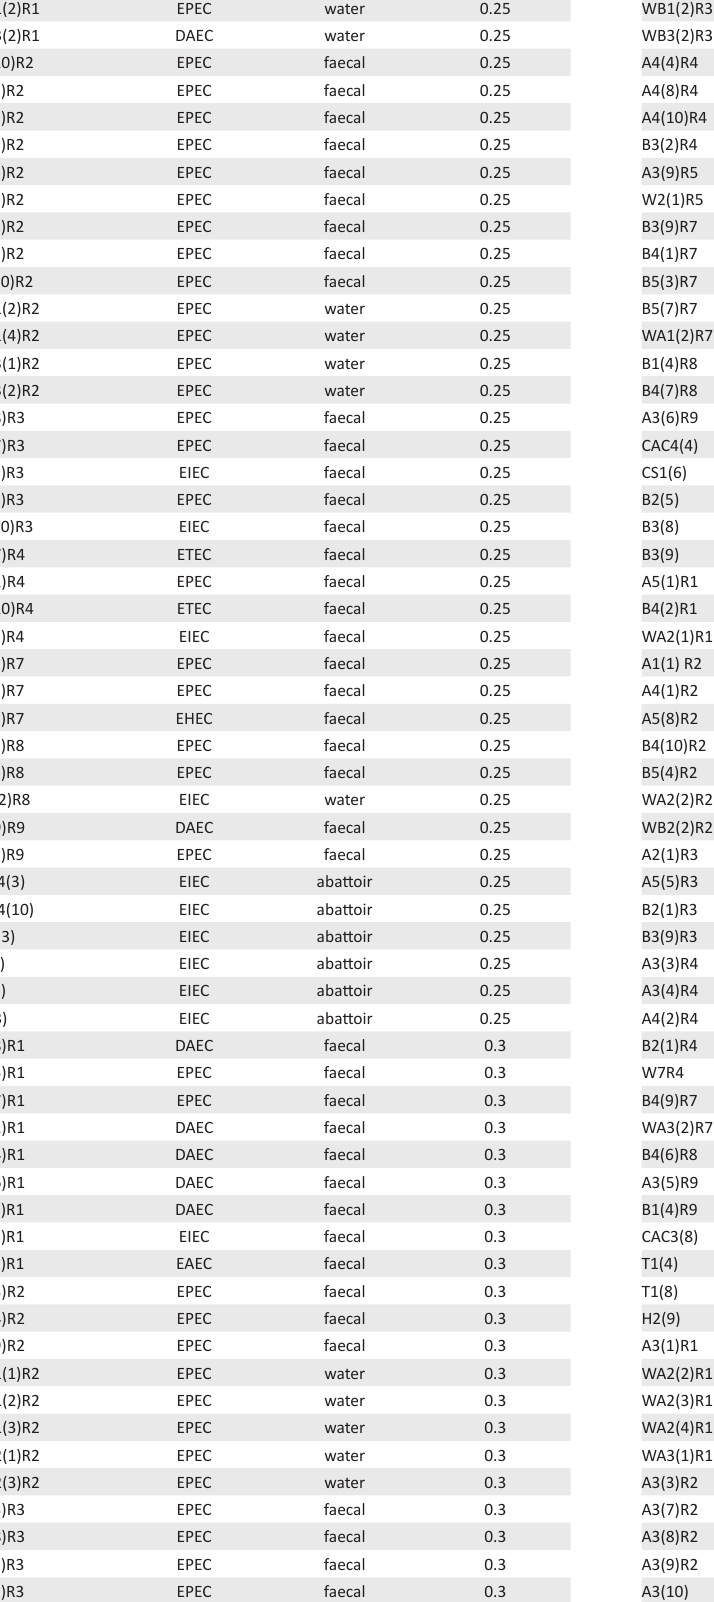
TABLE 4-A1 (Continues...): Multiple-antibiotic resistance index for all diarrheagenic E. coli pathotypes along the farm-to-fork continuum. Bacterial ID DEC pathotype